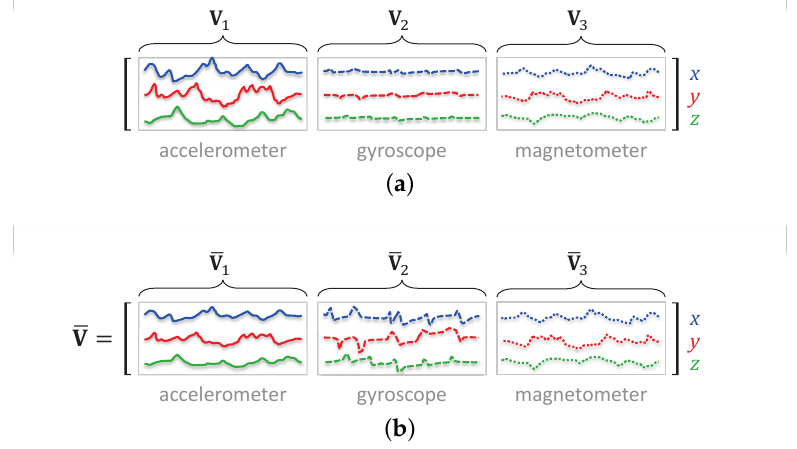
Figure 2. Concatenation of the sequences of different sensor types. ( a ) Accelerometer, gyroscope, and magnetometer sequences are concatenated along the time-sample dimension to obtain a joint 3 × 3 transformation; and ( b ) the three sequences are normalized to have unit variance (over the whole dataset) before applying SVD-based